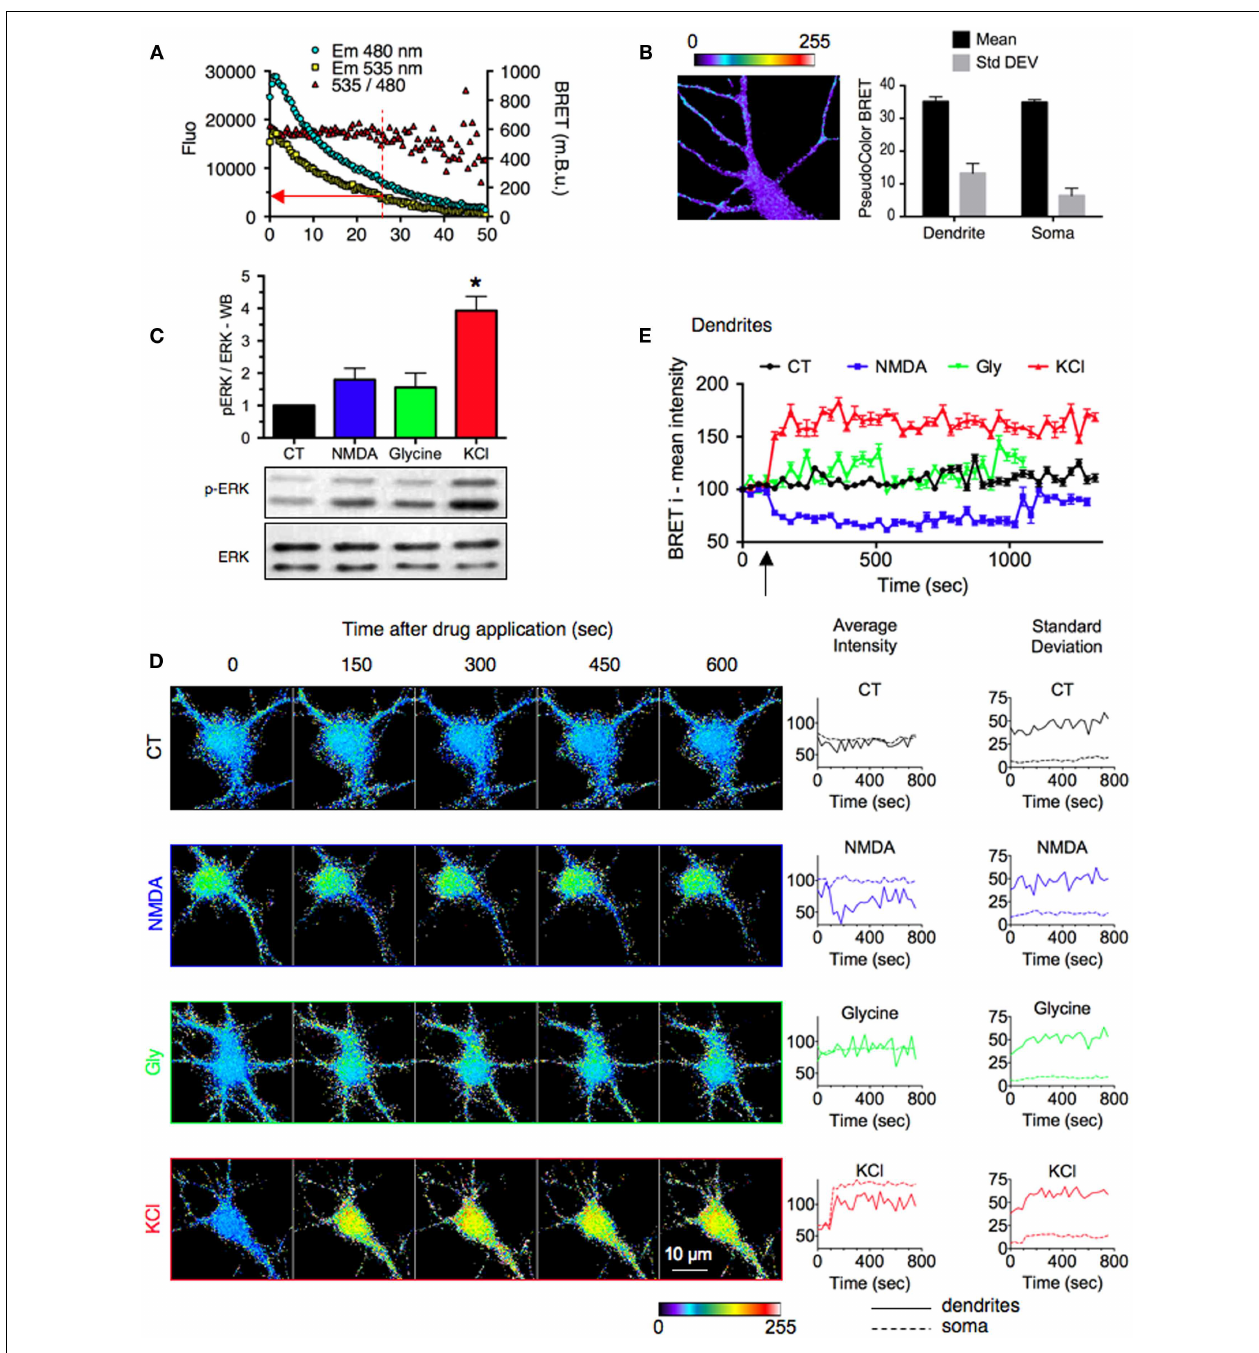
six neurons and seven regions per neuron. (C) ERK and phospho-ERK (p-ERK) staining quantified by western blot in hippocampal neurons stimulated or not (black) with NMDA (50 µ M, blue), Glycine and strychnine (200 and 1 µ M, respectively, green), or KCl (50mM, red) for 10min. (D) Real-time BRET imaging of four representative hippocampal neurons transfected with REV, in the stimulated conditions described in (A) . Changes of average intensity and standard deviation over time were measured on the soma and dendritic shaft of each image. (E) Intensities of BRET signals recorded on dendrites of neurons in BRET images over time. Each point of the graph represents the mean ± SEM obtained from three to six neurons and seven regions per neuron, for each time